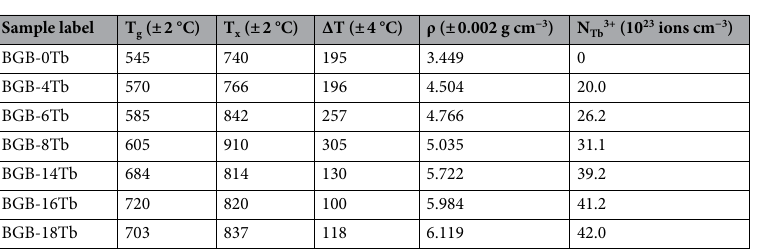
Table 1. Glass transition temperature (T g ), crystallization onset temperature (T x ), maximum crystallization temperature (T p ), thermal stability parameter (ΔT), density (ρ), and Tb 3+ ion density values for the BGB- x Tb